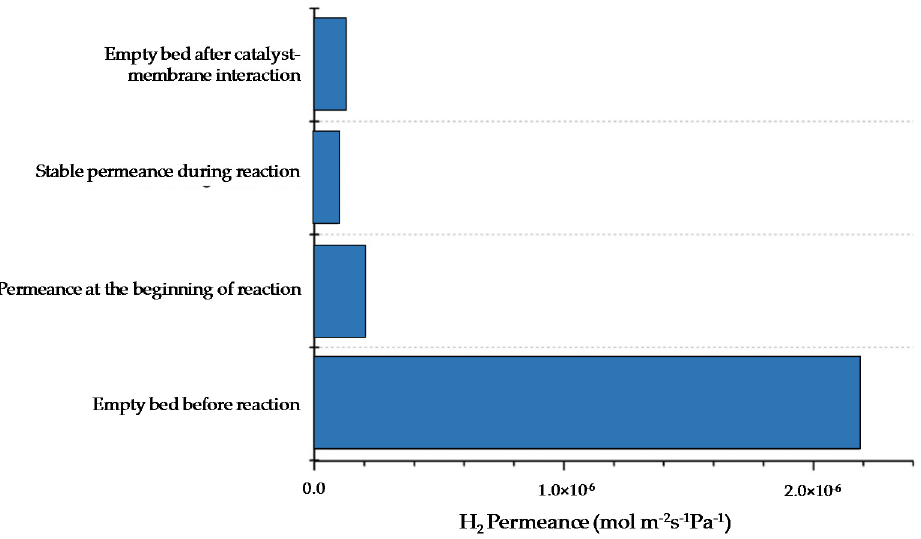
Figure 21. Comparison of H 2 permeance at different moments in time before and after interaction of the catalyst with the Pd surface (400 °C) [38].